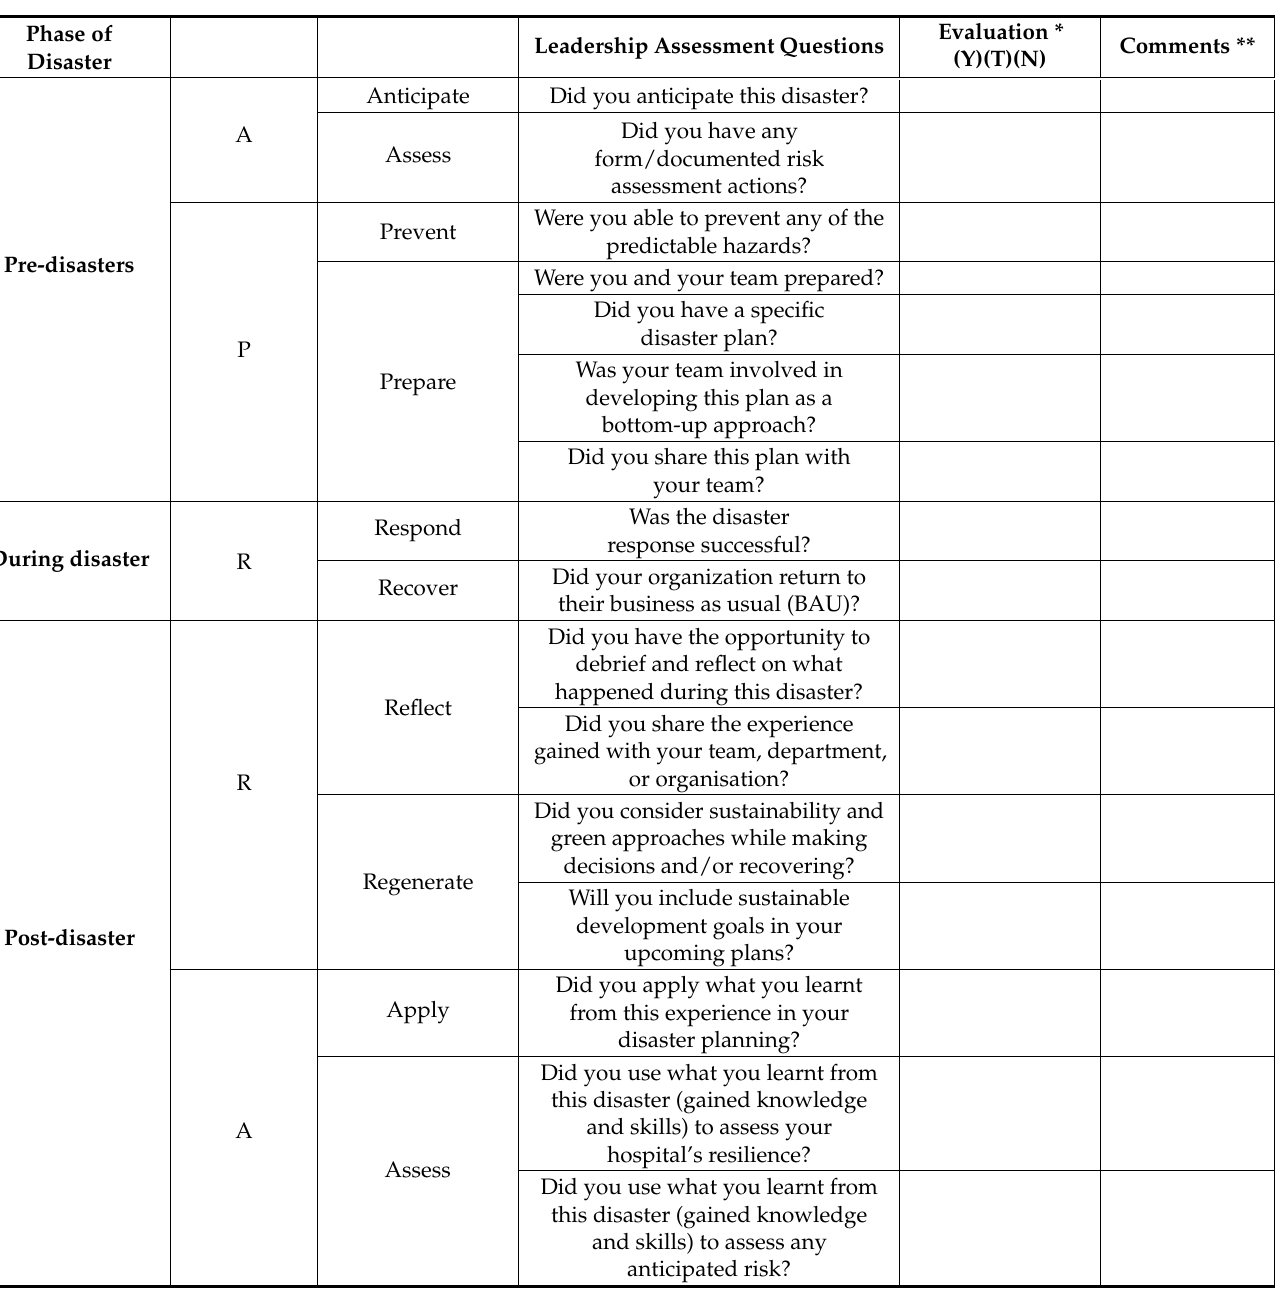
Table 5. Transformational Hospital Leaders Assessment (THLA) Checklist: Toward Disaster Re- silient